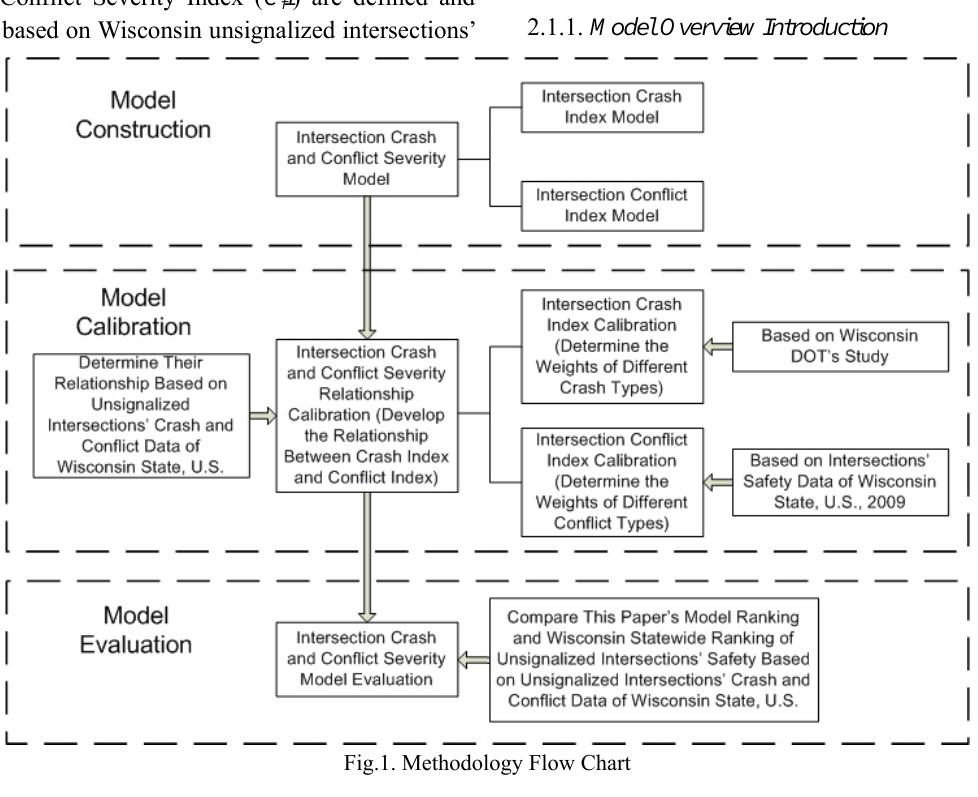
Fig.1. Methodology Flow